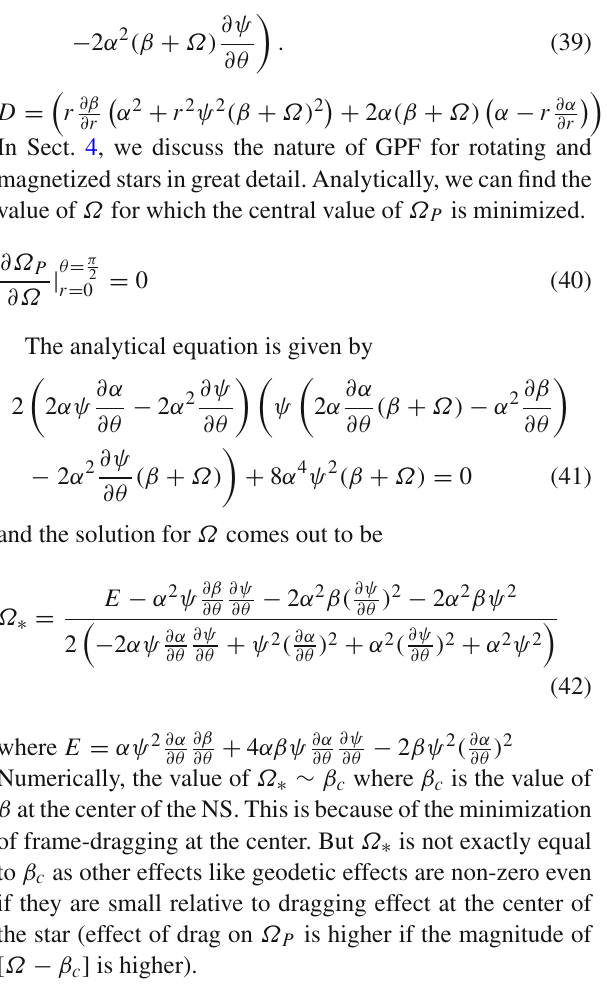
looking into the GR analog of inertial forces present. In